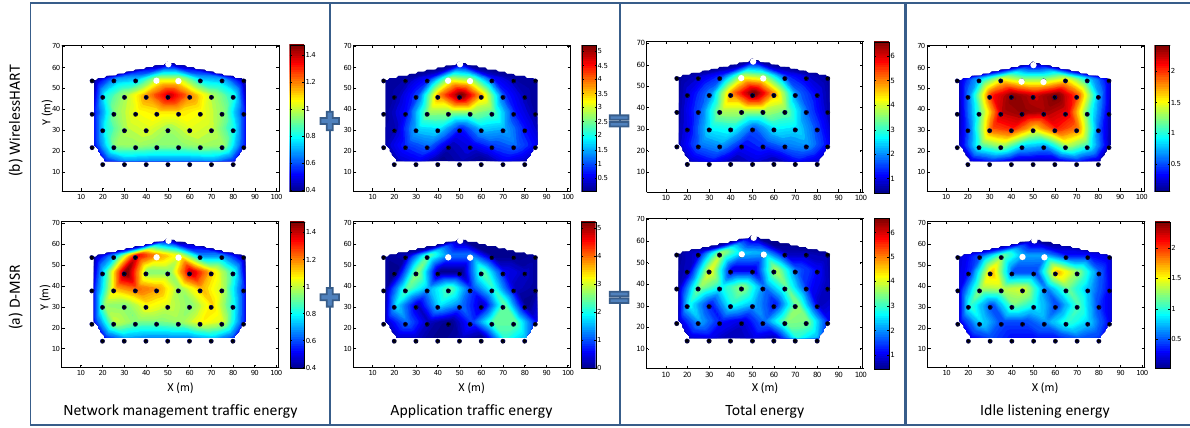
Figure 29. The energy consumption distribution in WirelessHART ( a ) and D-MSR ( b